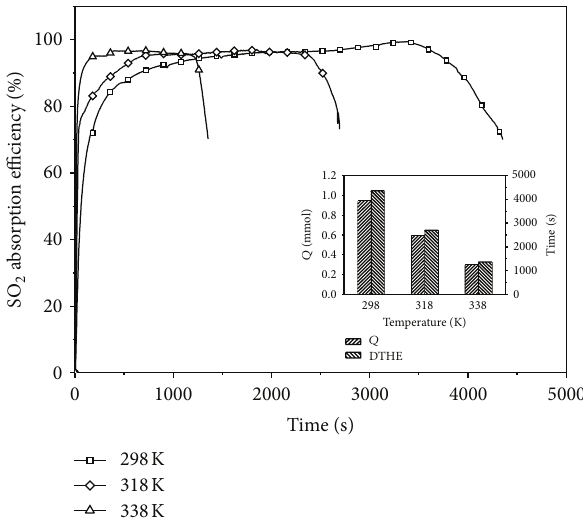
Figure 4: The effect of the temperature (SO 2 , 2500 ppm; gas flow, 0.12m 3 /h; absorption solution, 100mL; O 2 , 5 vol%). The inset shows the absorption amount of SO 2 and DTHE.